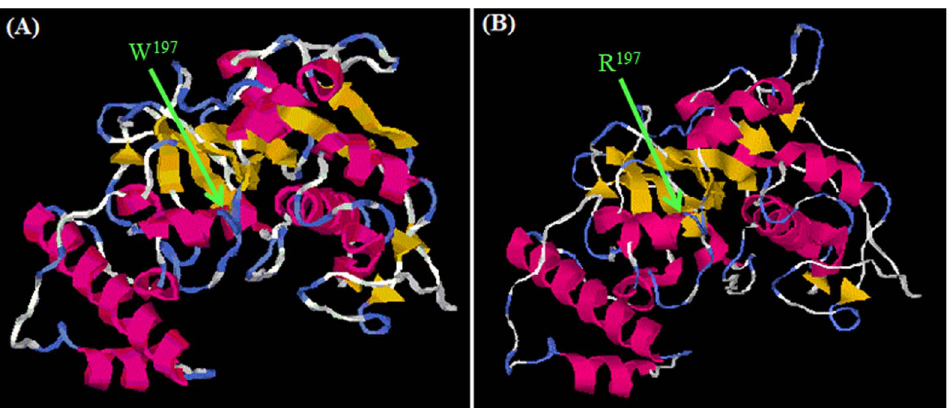
Figure 3. I-TASSER result showing tertiary structure predictions for RS33 (Tryptophan variant) and RS31 (Arginine variant) of Der f 1 protein [36– 38] . A: specimen RS33; B: specimen